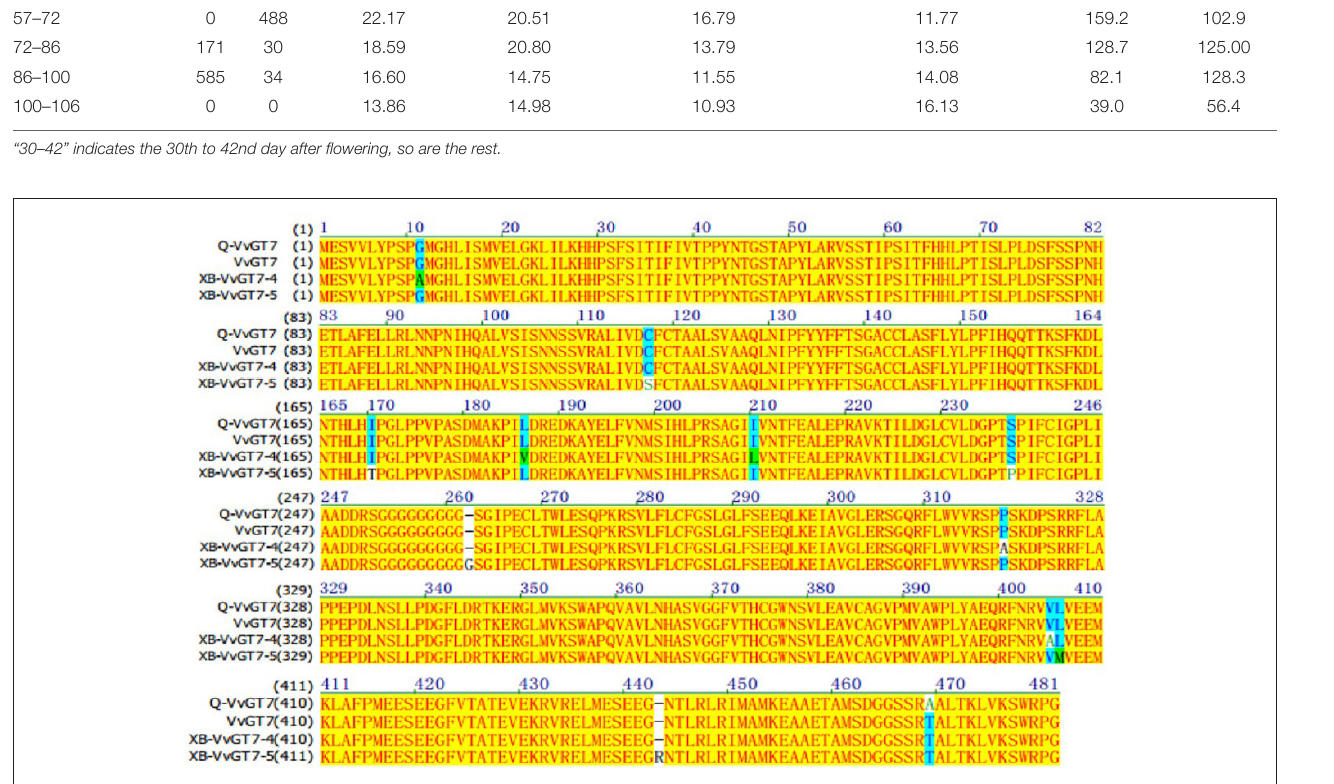
FIGURE 4 | Amino acid sequence alignment of VvGT7 from “Gewürztraminer” and “Muscat blanc à Petit grain” grape berries. Q-VvGT7 represents the VvGT7 sequence of “Gewürztraminer” grapes; XB-VvGT7-4 and XB-VvGT7-5 represent the sequences of two VvGT7 alleles from “Muscat blanc à Petit grain” grapes, VvGT7 represents the sequence from “Pinot noir” grapes published in